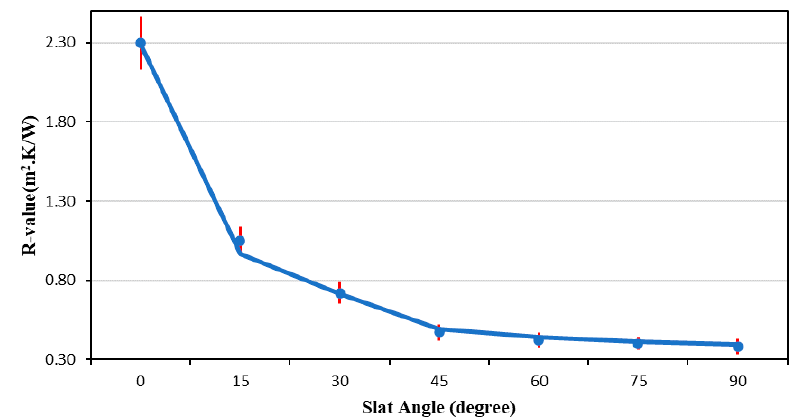
Figure 2. Variation of a dynamic insulation system R-value with the rotation angle based on experi- mental data [53]. Reproduced from [53], Elsevier: Amsterdam, The Netherlands, 2020.